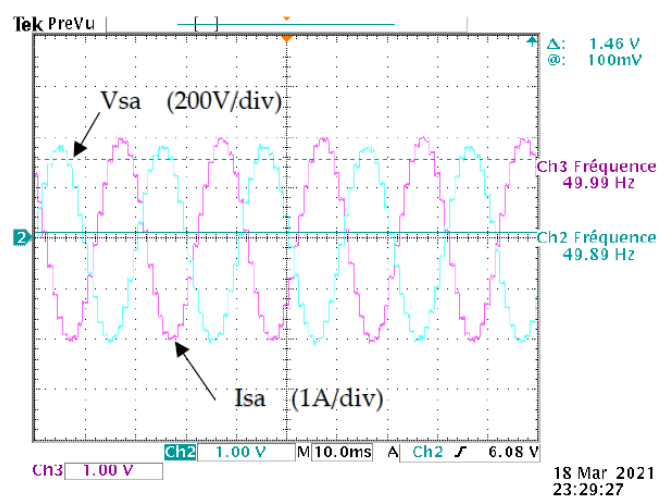
Figure 14. MLI signals.